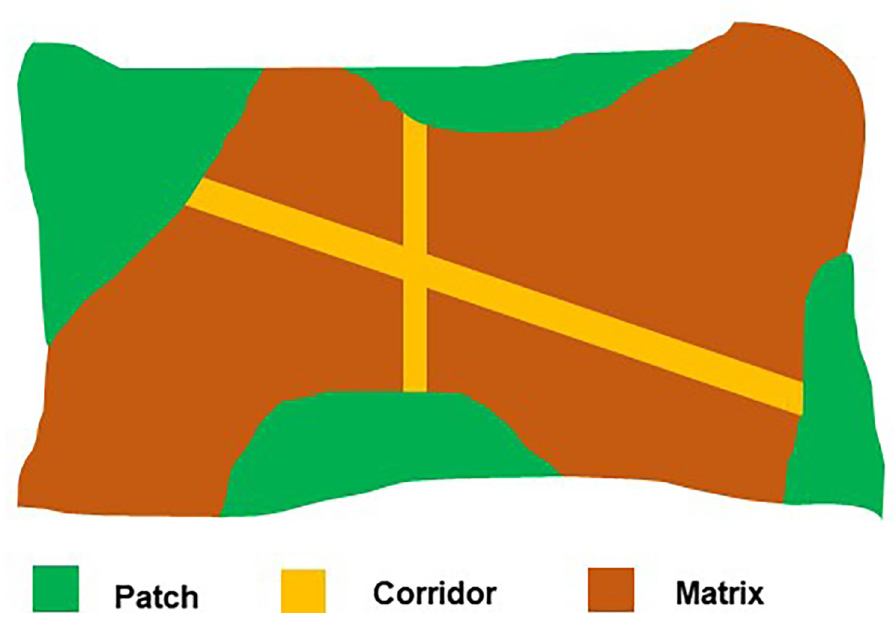
Fig 1. Patch-corridor-matrix